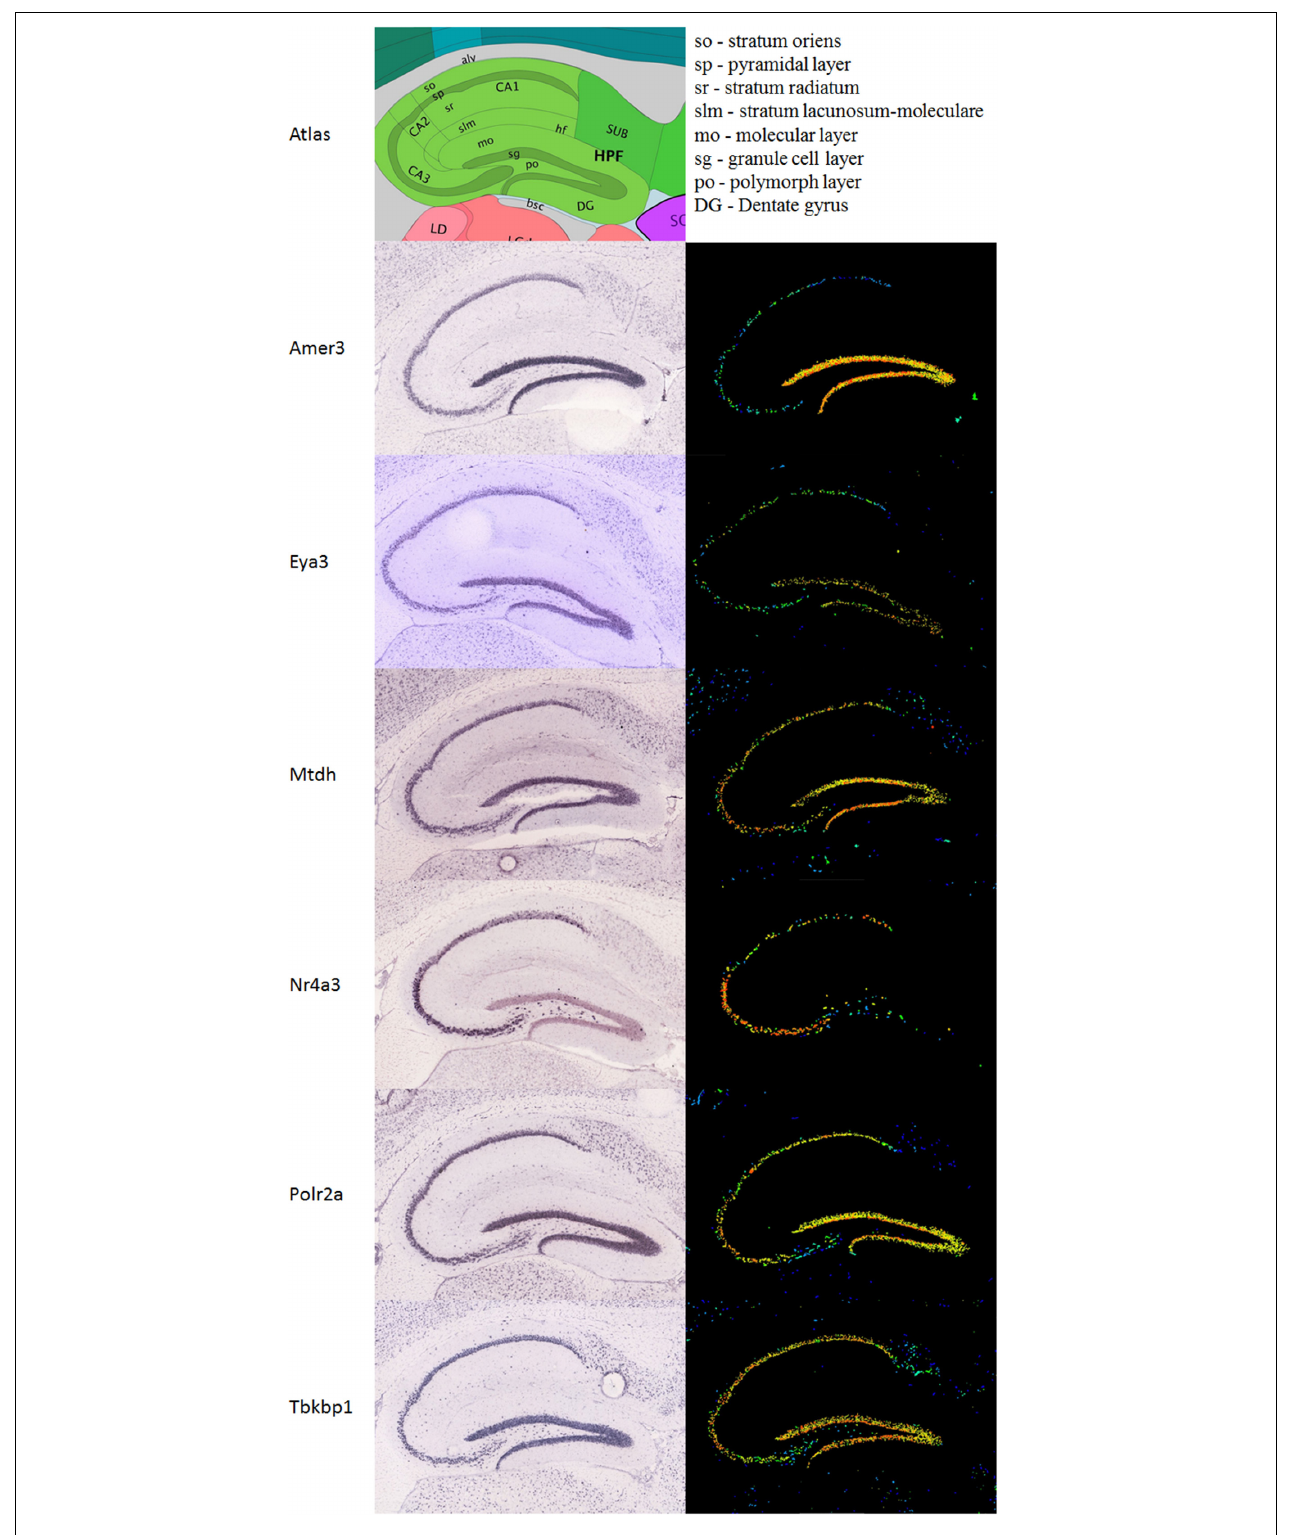
FIGURE 2 | Expression of the six candidate genes in the hippocampus. Immunohistochemistry (ISH) is presented in the left column, the expression in the same sagittal slices in the right column. An atlas is